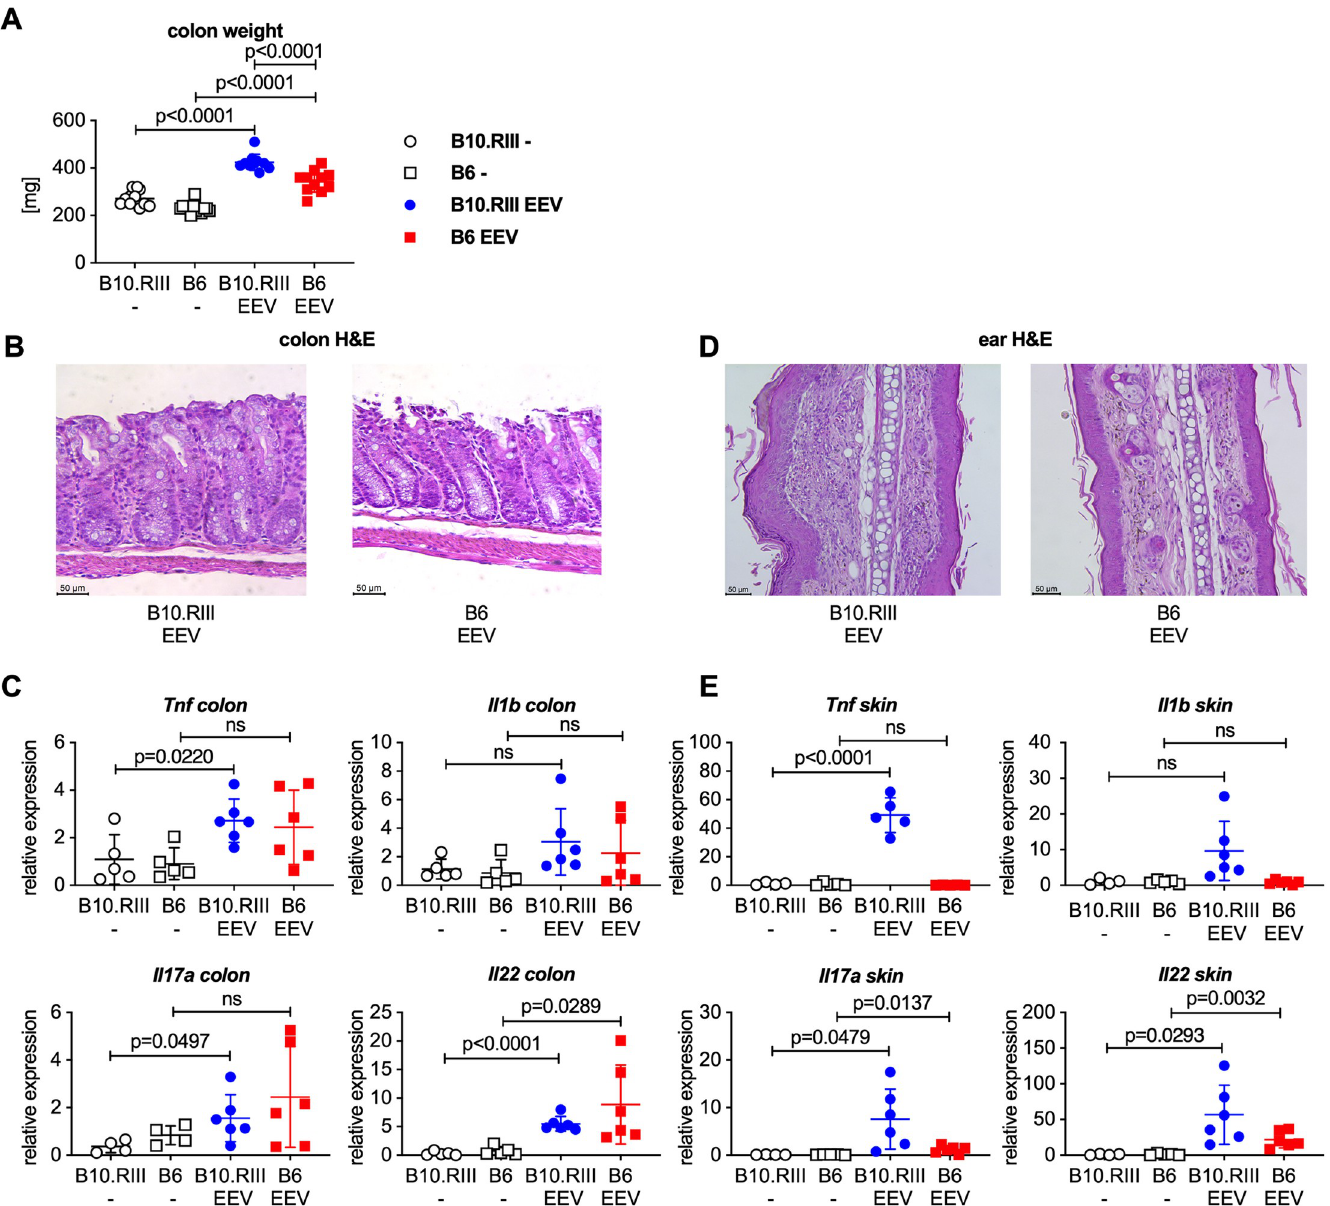
Fig 5. Male B6 mice develop colitis and mild psoriasis-like skin disease after hydrodynamic injection of IL-23 EEV. Data are from the animals in the experiment shown in Fig 4. (A) Colon weight on day 14. (B) Representative H&E stained sections of day 14 colon from IL-23 EEV injected B10.RIII and B6 mice, scale bar 50 μ m. (C) Gene expression for Tnf , Il1b , Il17a , and Il22 in the colon was analyzed by qPCR. (D) Representative H&E stained sections of day 14 ears from IL-23 EEV injected B10.RIII and B6 mice, scale bar 50 μ m. (E) Gene expression for Tnf , Il1b , Il17a , and Il22 in forepaw skin was analyzed by qPCR.